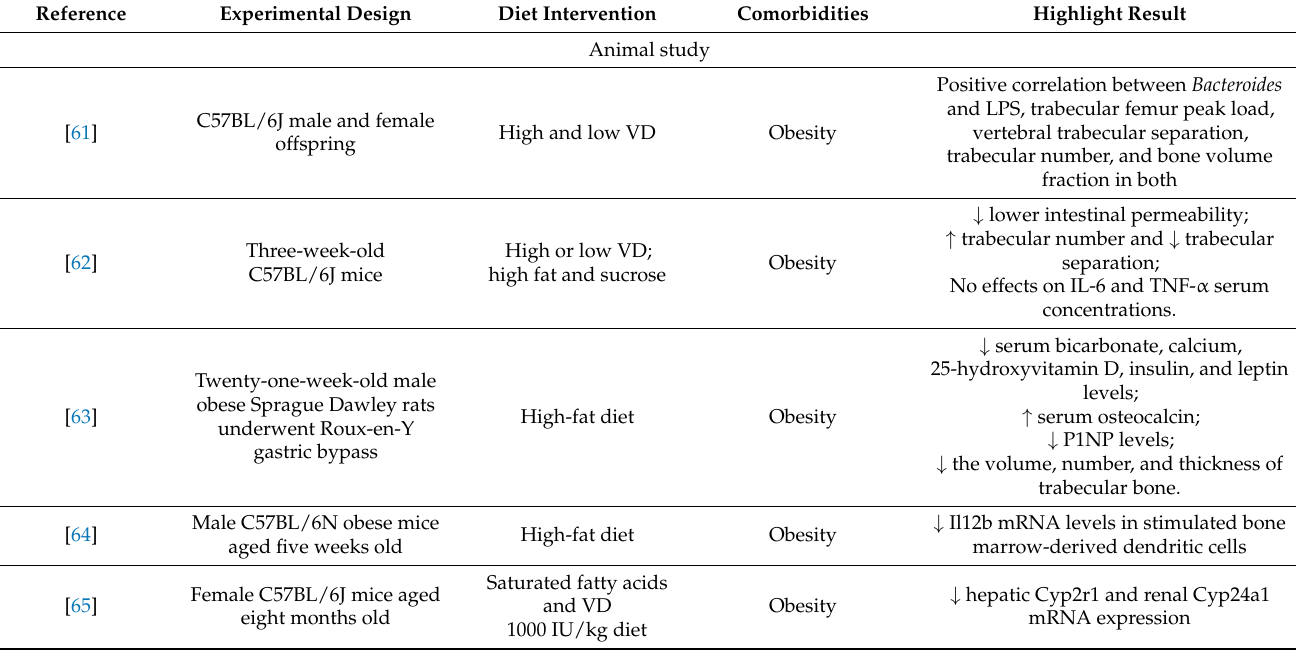
Table 4. VD on bone